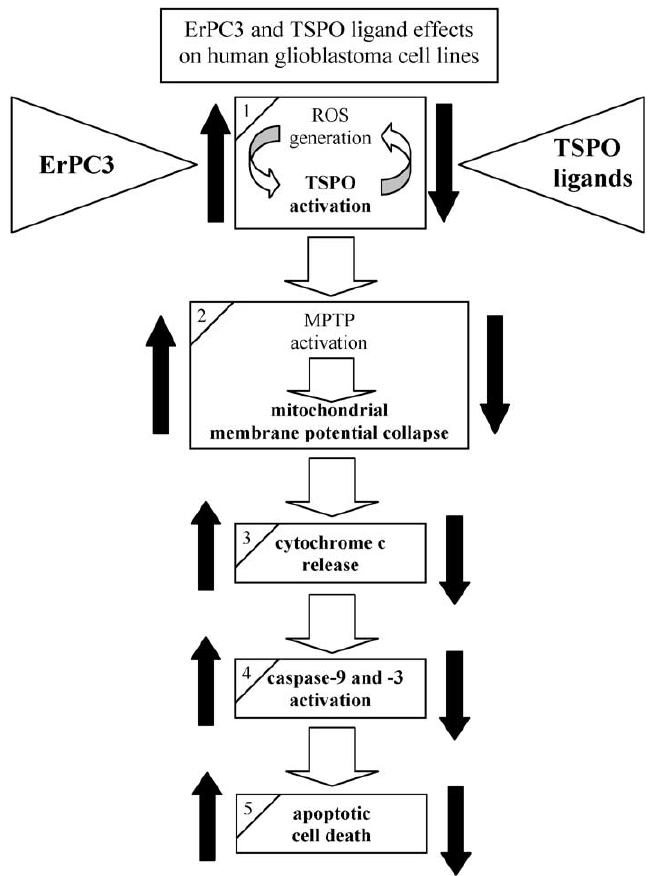
Fig. 8. The present study indicates that TSPO ligands can reduce activation by ErPC3 of the mitochondrial apoptosis cascade, including TSPO activation (blocks 1–5). The black, upward pointing arrow mark activation by ErPC3 of the steps indicated in the blocks. The black, downward pointing arrows depict counteraction of these ErPC3 effects by the TSPO ligands PK 11195 and Ro5 4864. We assume that the activation of TSPO may involve ROS generation (block 1). Our study further demonstrated unequivocally that activation of the mitochondrial apoptosis pathway by ErPC3 includes collapse of mitochondrial membrane potential (block 2), possibly due to direct interactions between ROS, the TSPO and the